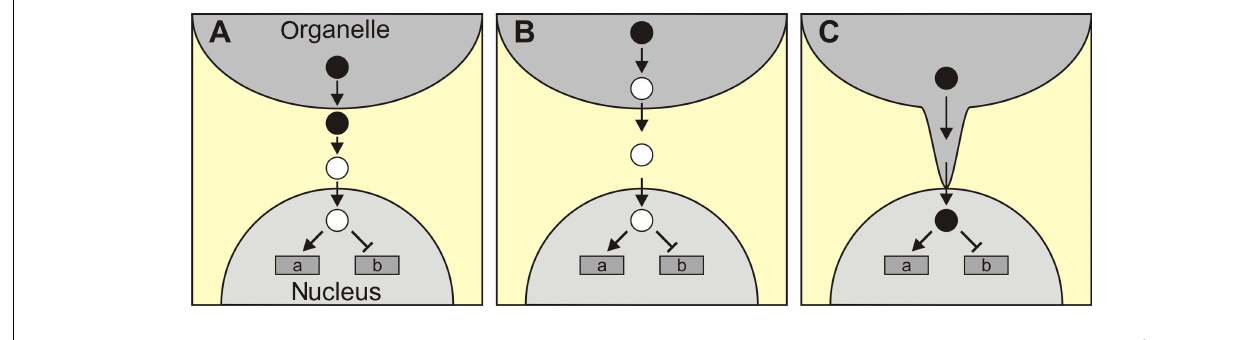
generated in the organelle might not even leave the organelle. 1 O 2 serves here as an example, as it could, in principle, generate volatile oxidation products of carotenoids that serve as “downstream” messengers. (C) Direct delivery of the signaling molecule to the nucleus via